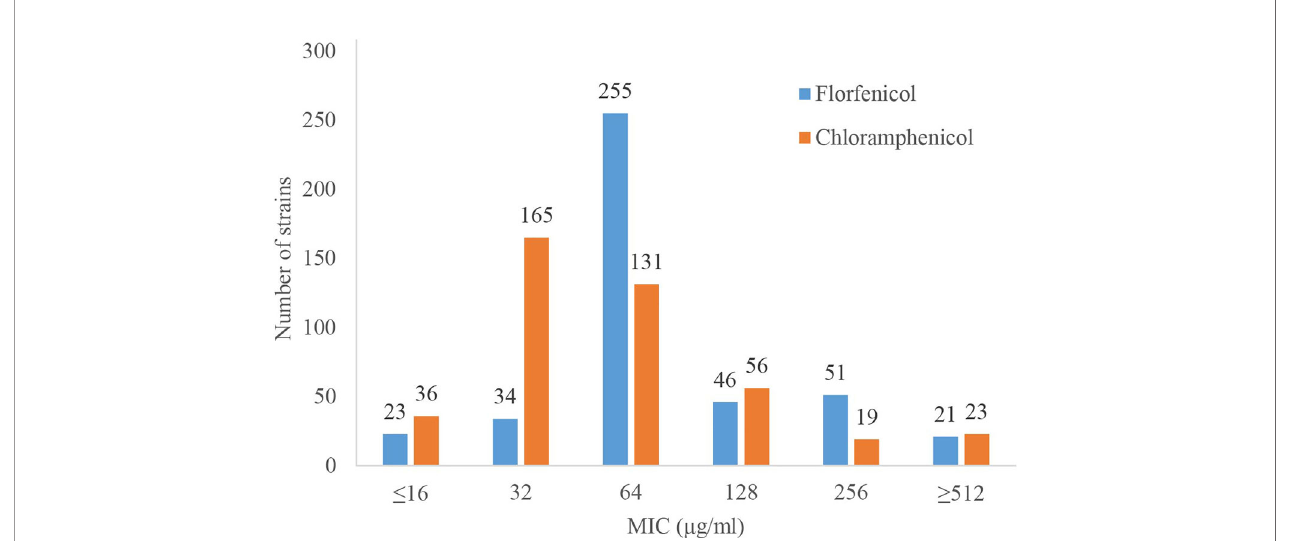
FIGURE 1 | MIC results of the 430 clinical P. aeruginosa isolates against fl orfenicol and chloramphenicol.